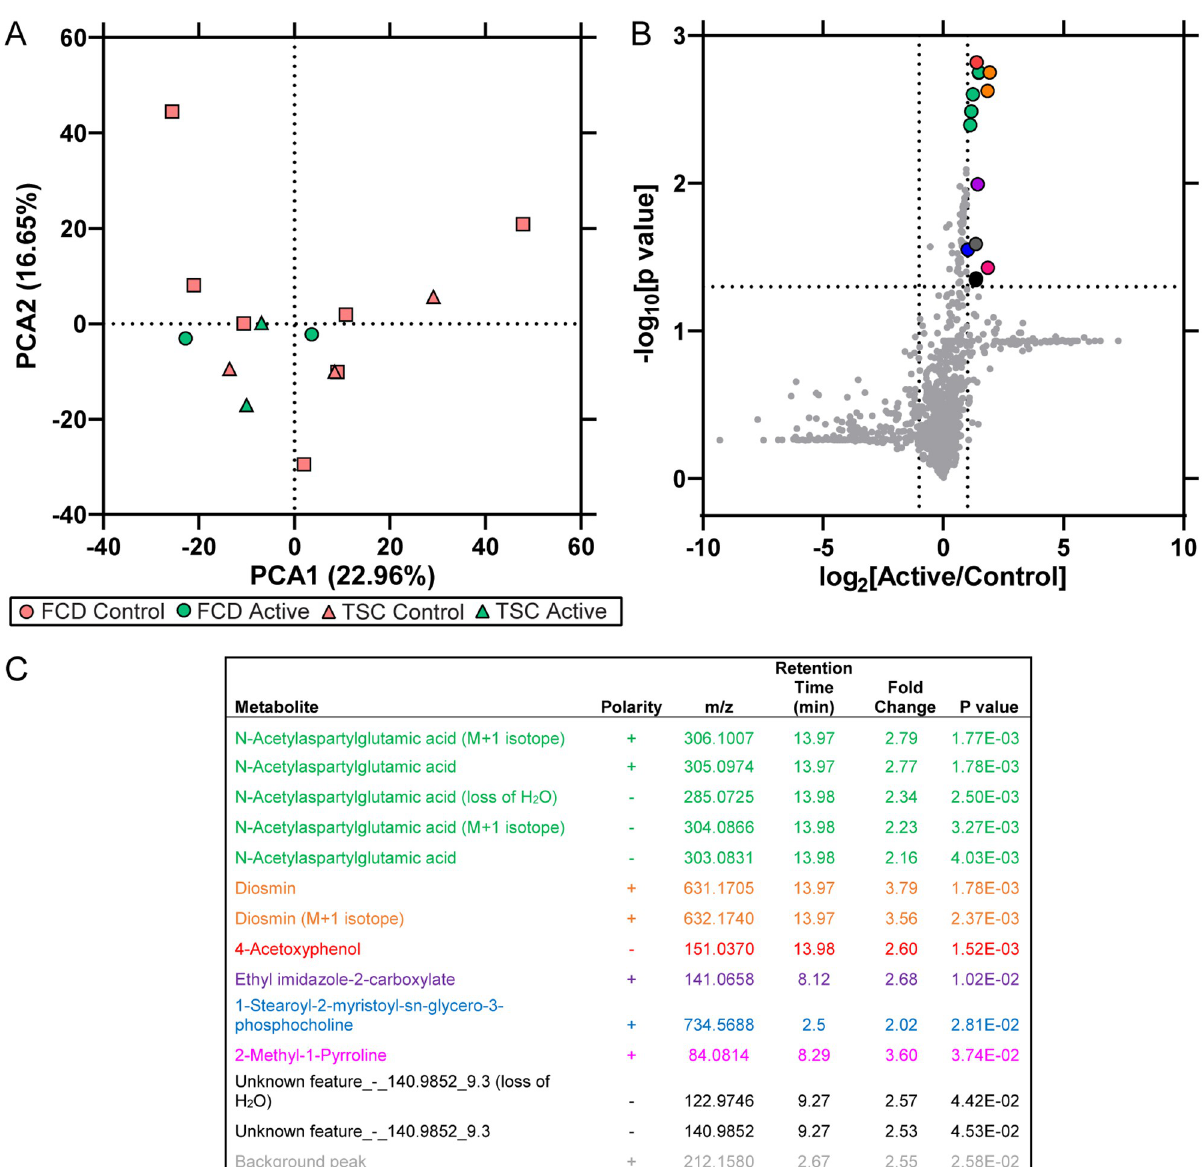
Fig 4. Metabolomics in whole brain homogenate. Global polar metabolomics by LC-MS was performed on surgically resected brain tissue from Active and Control participants. A) PCA indicated distribution of participants, as well as clinical diagnoses (FCD, TSC). There was no segregation of Active and Control participants in PCA1 (p = 0.32) or PCA2 (p = 0.48). B) Differential expression analysis (p < 0.05, log 2 (fold change) > 1) identified 14 metabolite features that were increased in Active participants, associated with the indicated annotations detailed in C)